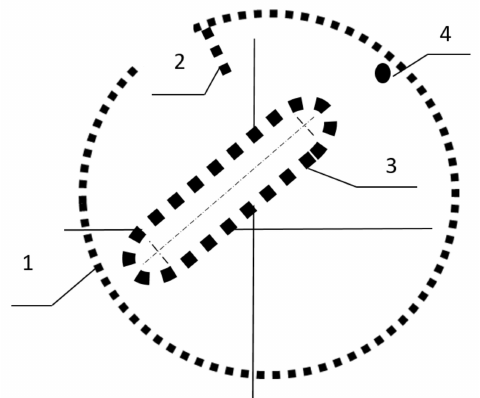
Figure 4. Design and technological scheme of the device for assessing the suitability of varieties and hybrids for mechanized harvesting: 1—rod drum; 2—blade; 3—finger slide; 4—shaker.